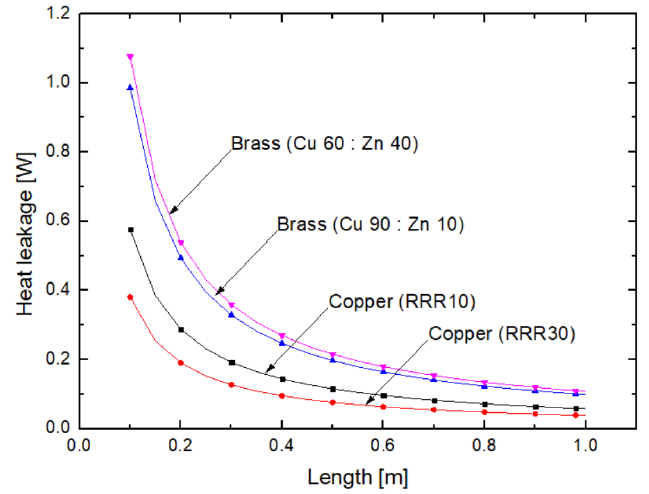
Figure 4. Heat leakage through the current lead composed of different materials as a function of its length.